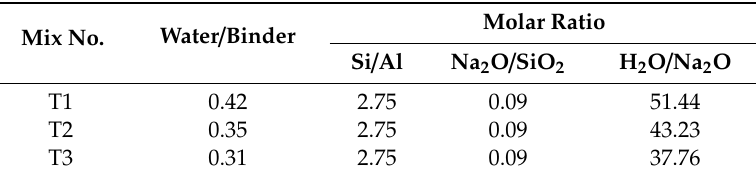
Table 3. Critical molar ratios and water / binder of all